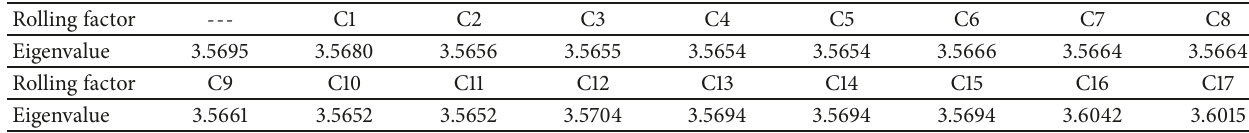
Figure 5: Comparison of each factors of the three generations in 2014. Table 7: Level-wise substitution set of each evaluated metarisk variables eigenvalues in 2014.